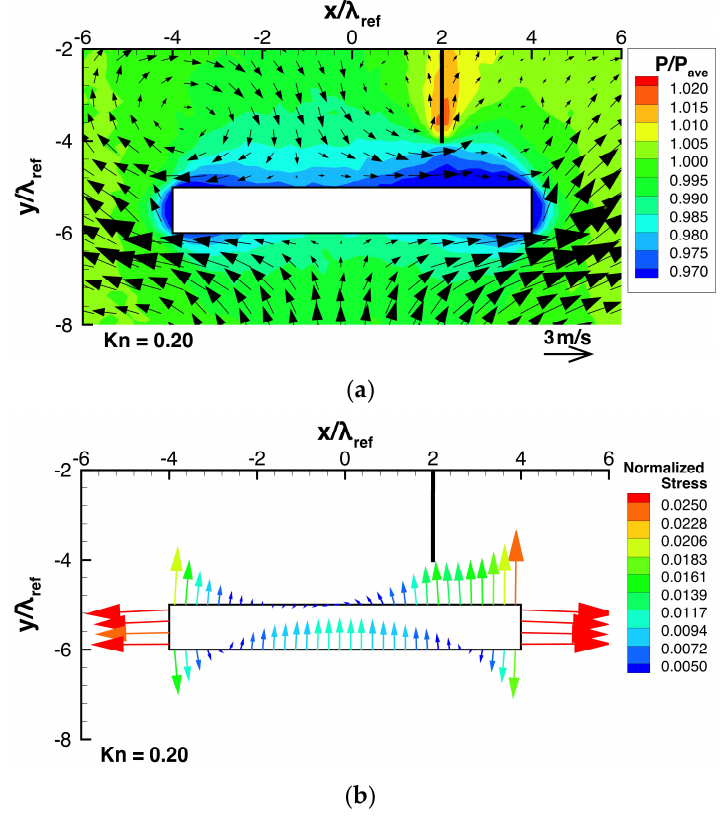
Figure 9. ( a ) Pressure and flow distributions around the beam and ( b ) stress distributions on the beam surfaces for a beam height of ℎ = 0.125𝑤 , at Kn = 0.2 .